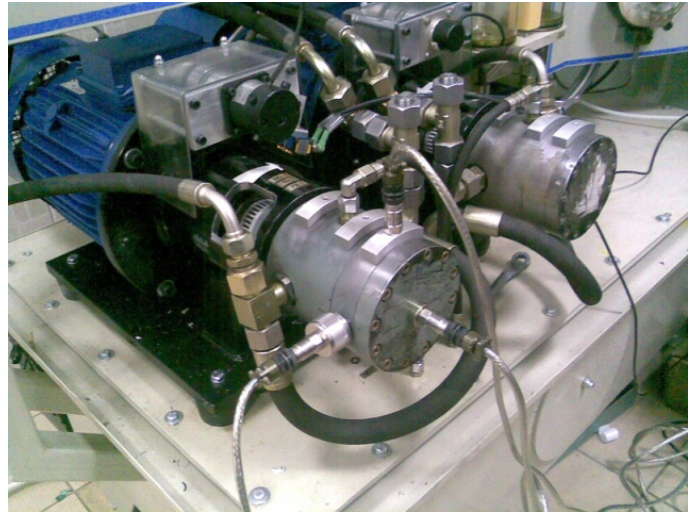
Figure 2. View of the tested pump on the laboratory station.